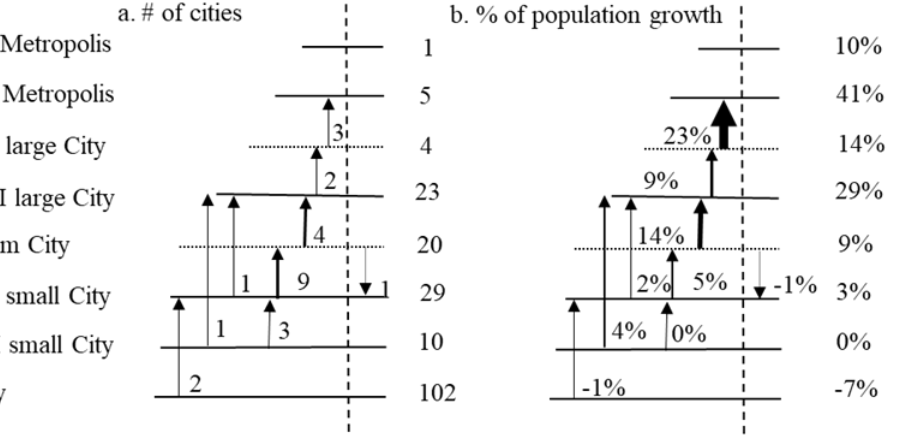
Figure 6. Number of cities and share of cities’ increment to total population growth across hierarchies in 2010 – 2020.